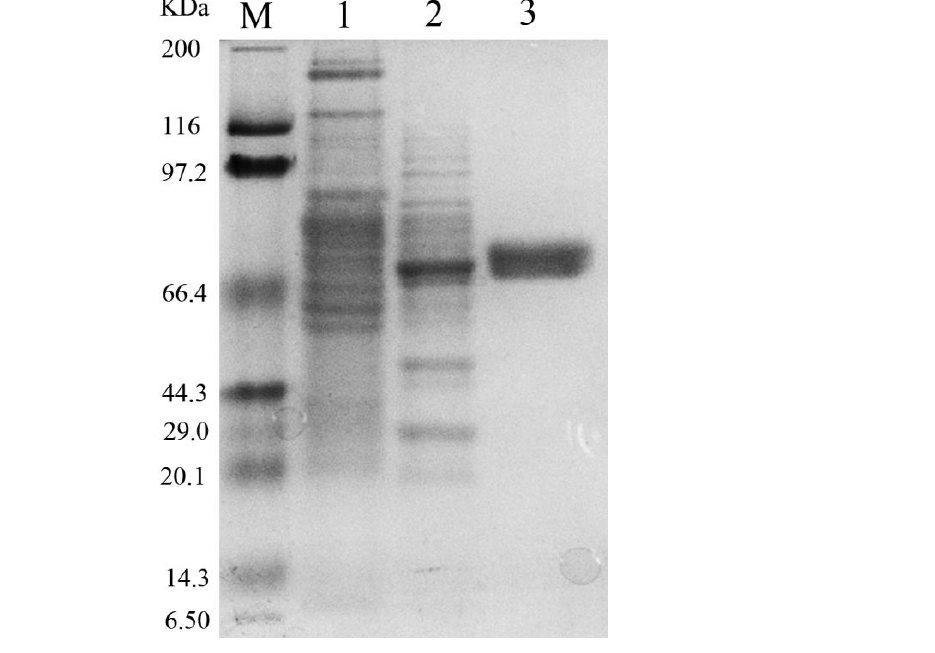
Table 2. Compared with cellulase and hemicellulose from coral and Holotrichia parallela. Family Cazy-activities